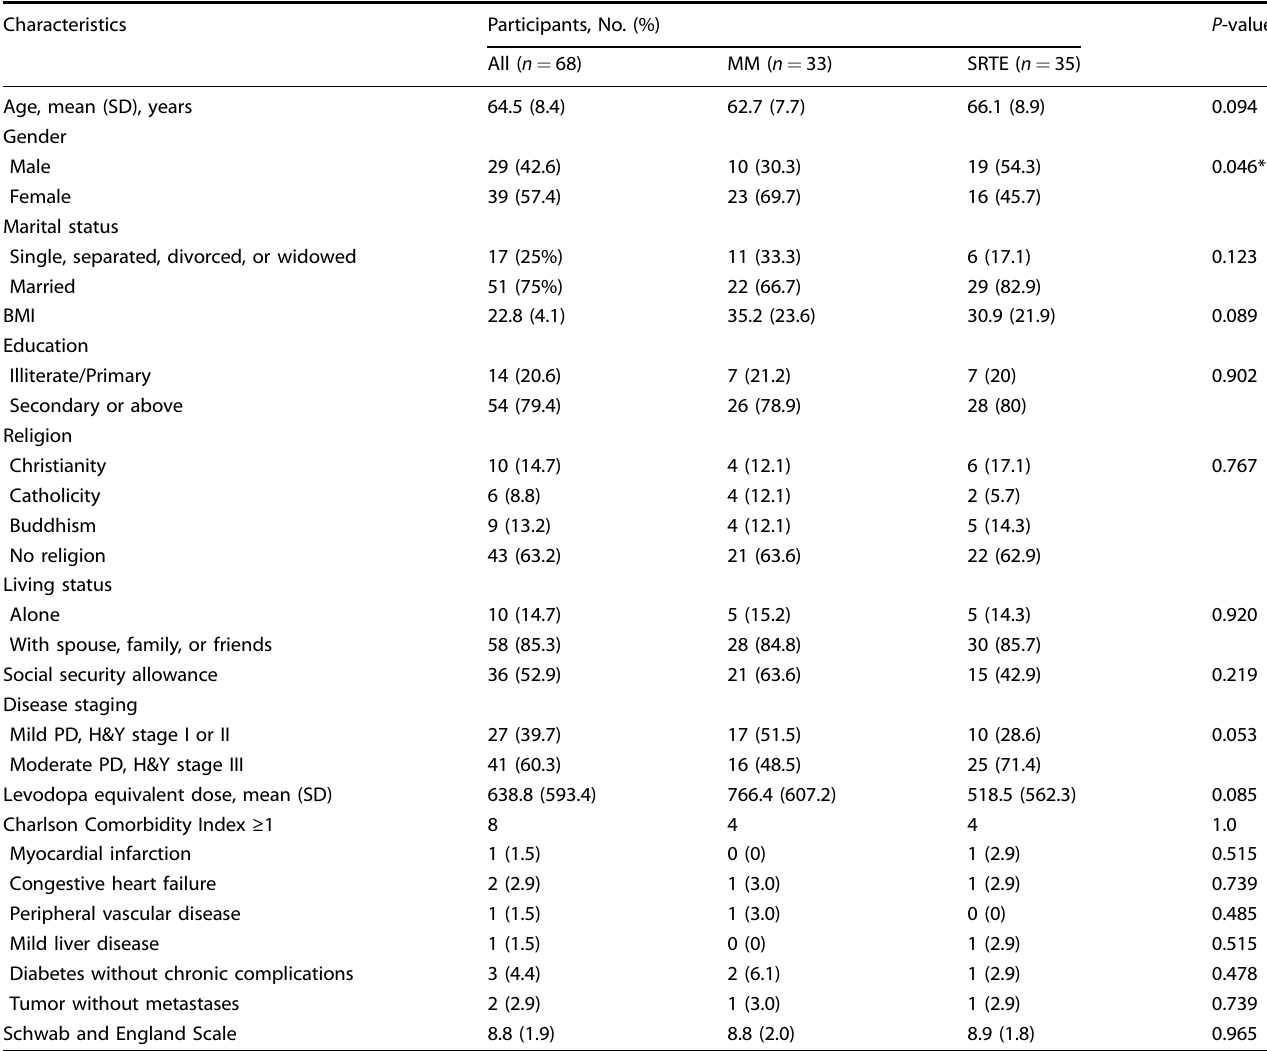
Table 1. Baseline socio-demographic characteristics of the participants ( n =